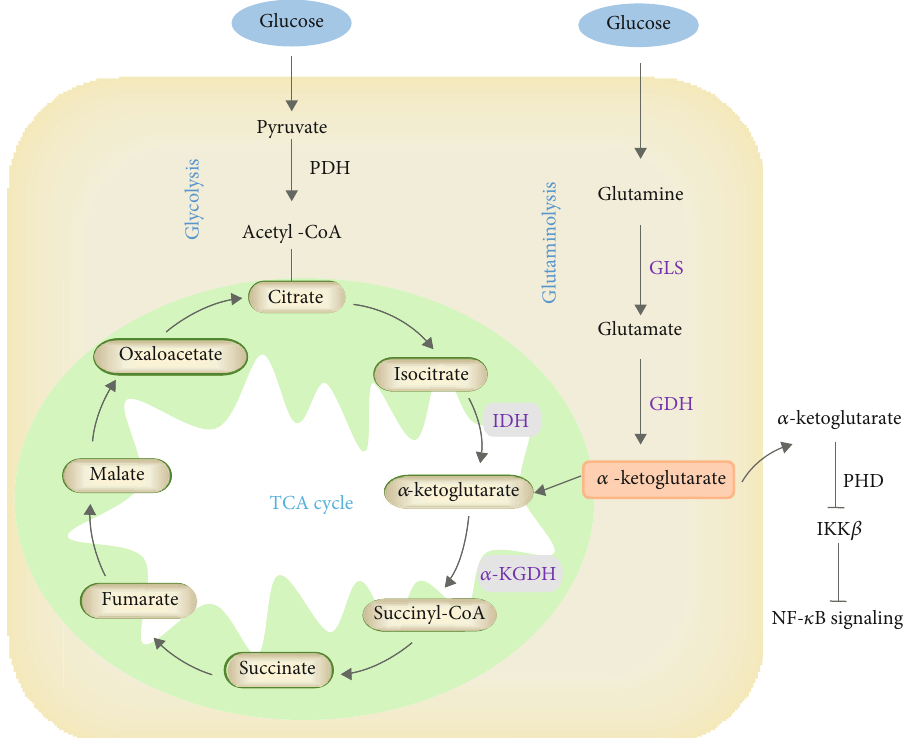
Figure 1: α -Ketoglutarate metabolism in macrophages. α -Ketoglutarate is generated from isocitrate by the oxidative decarboxylation of IDH in the TCA cycle or glucose via glycolysis. Additionally, glutamine could be converted into α -ketoglutarate under the catalysis of GDH and GLS via glutaminolysis. Then, α -ketoglutarate is metabolized into succinyl-CoA catalyzed by α -KGDH in the TCA cycle. In addition, GDH- mediated α -ketoglutarate can inhibit IKK β activation and block NF- κ B